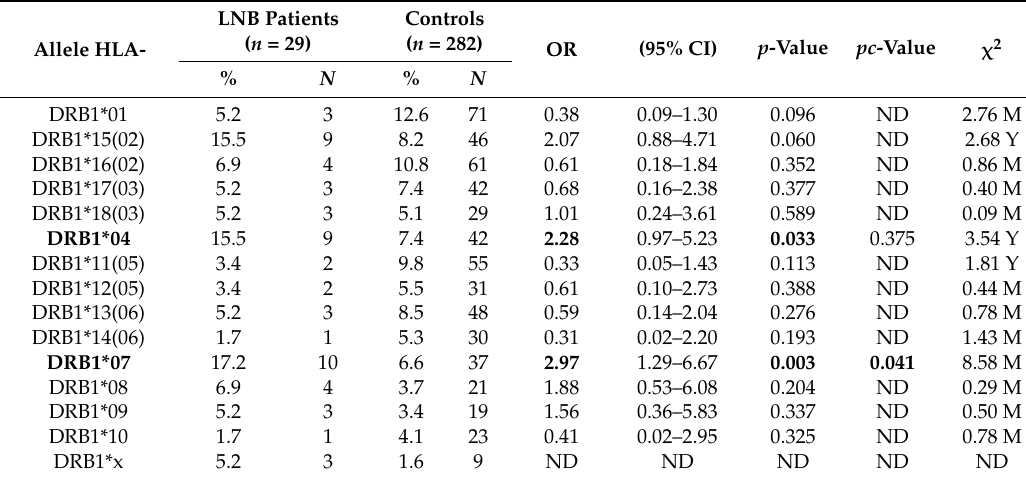
Table 4. The frequency of DRB1* alleles studied in-patients with Lyme neuroborreliosis and healthy controls from